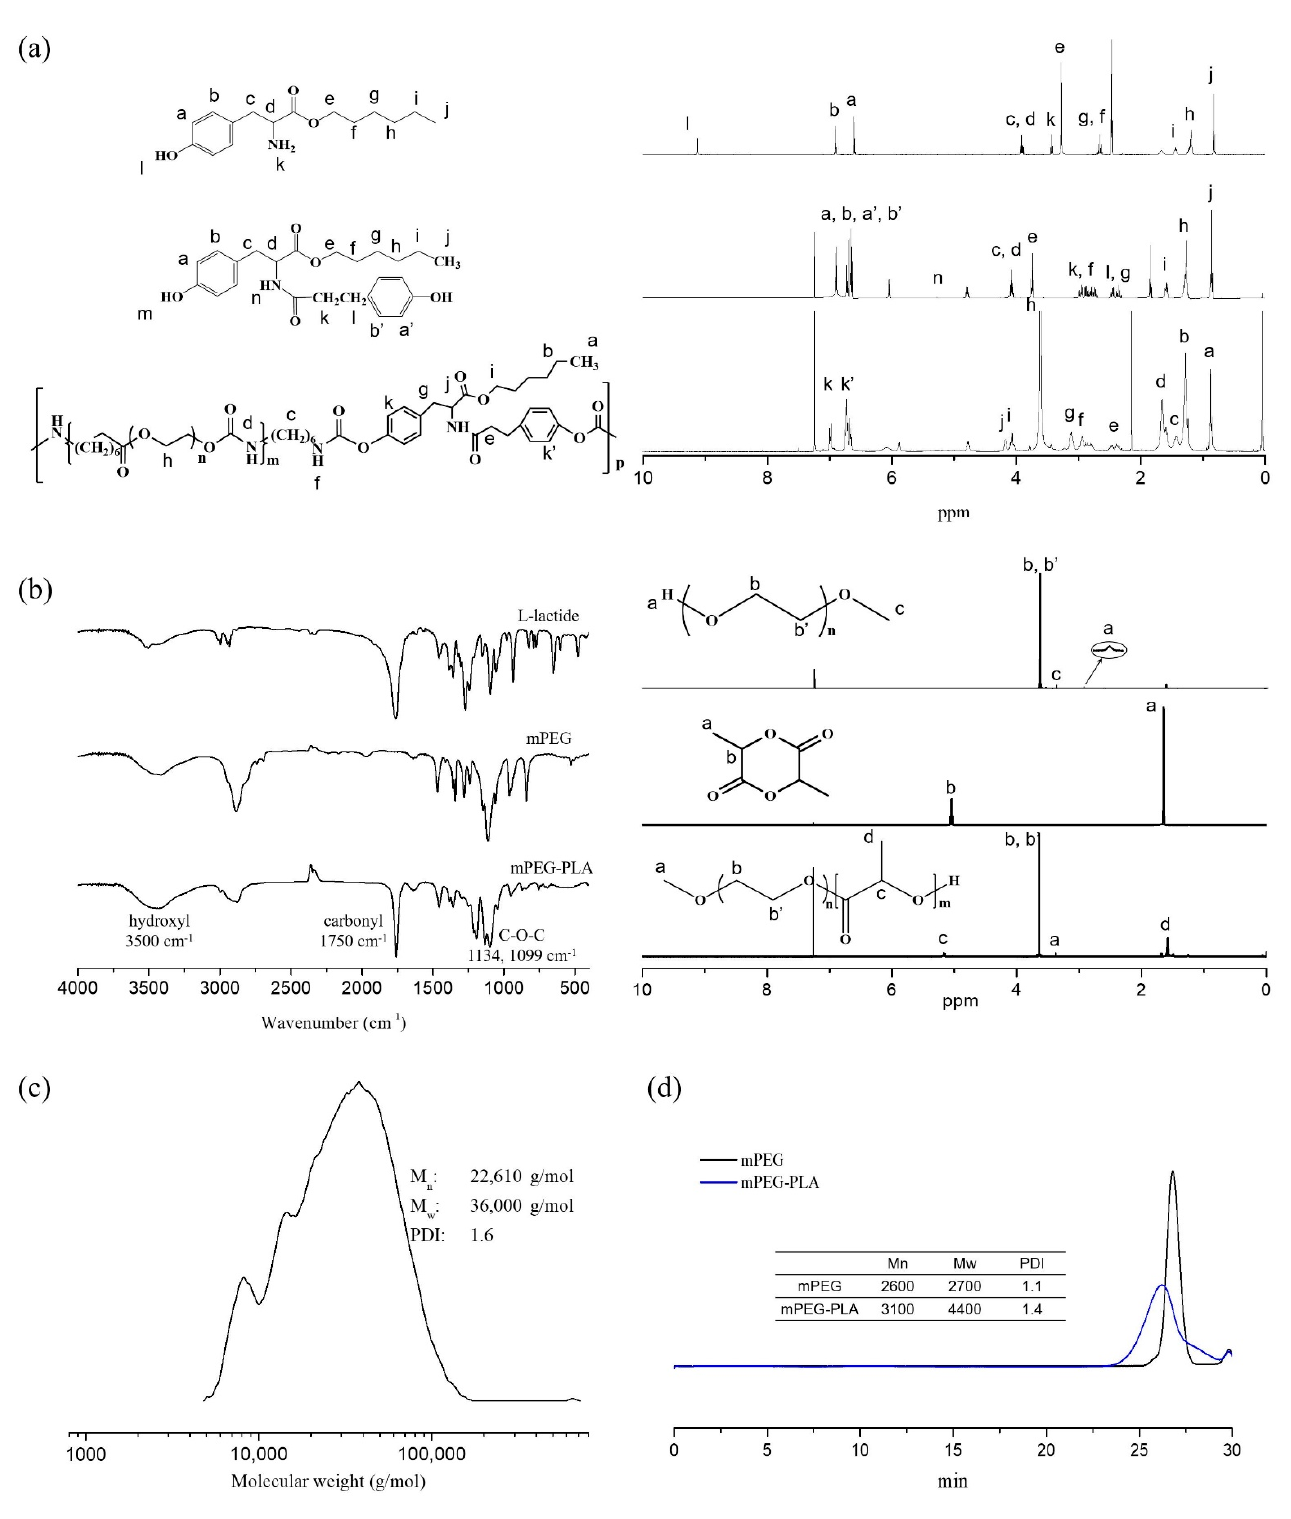
Figure 1. ( a ) 1 H-NMR spectra of TH, DTH, and LTU; ( b ) FT-IR and 1 H-NMR spectra of L-lactide, mPEG, and mPEG-PLA; GPC results of ( c ) LTU and ( d )